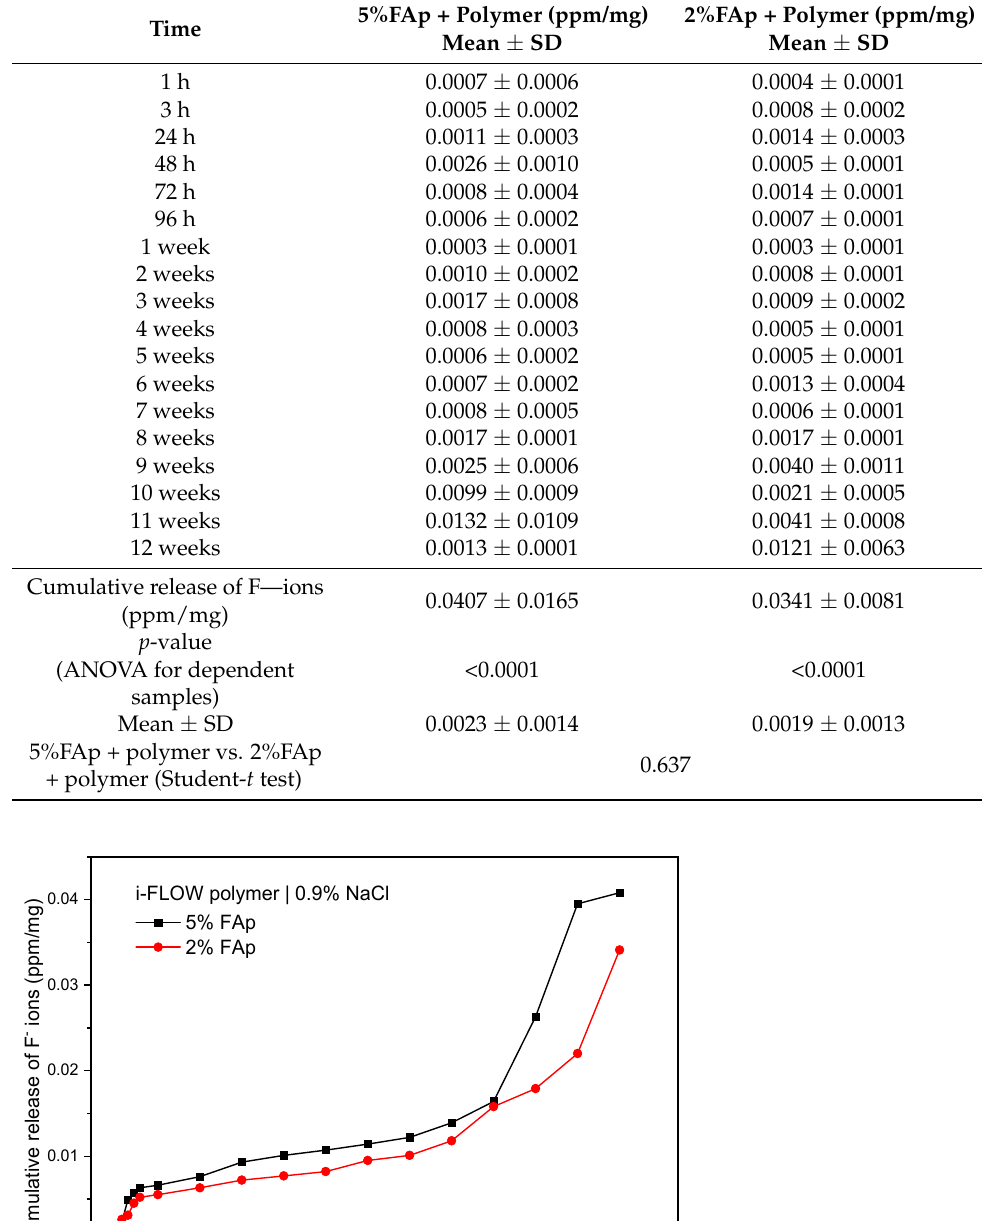
Table 1. Release of fluoride ions (ppm/mg) from 5%FAp + polymer and 2%FAp + polymer materials into saline solution (0.9% NaCl).